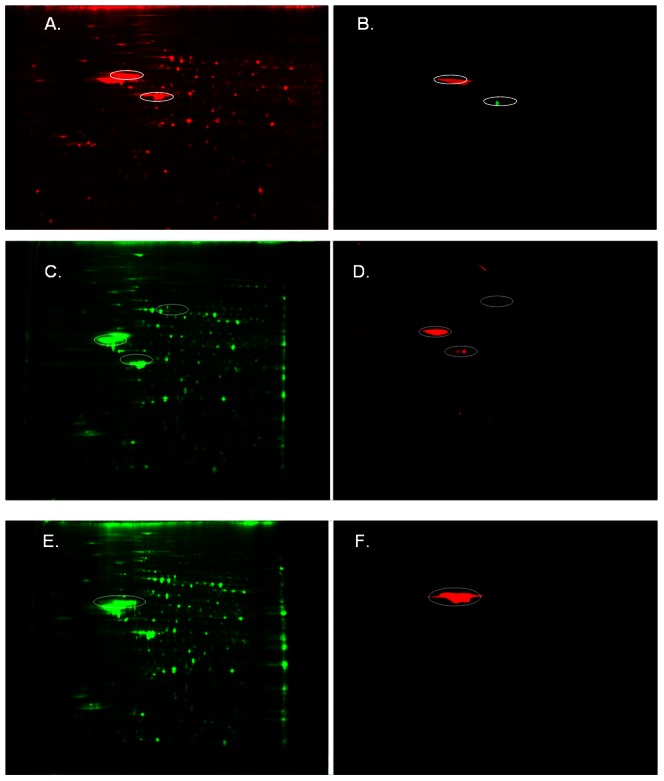
Actin and tubulin were phosphorylated after mood stabilizer treatment.A. 2D-DIGE gel image stained with Sypro Ruby stain showing phosphorylation of synaptoneurosomal preparations of saline treated animals (controls). B. location of actin identified spots (green spot) and tubulin (red spot) in saline treated preparations. C. Spots identified with actin antibodies during Western blots (circled) of synaptoneurosomal preparations after mood stabilizer treatment. D. Western blot identification of phosphorylated actin (circled). E. 2D-DIGE gel image showing phosphorylation after mood stabilizer treatment and the location of tubulin identified spots as indicated by circle. F. Spots identified with tubulin antibodies (circled).